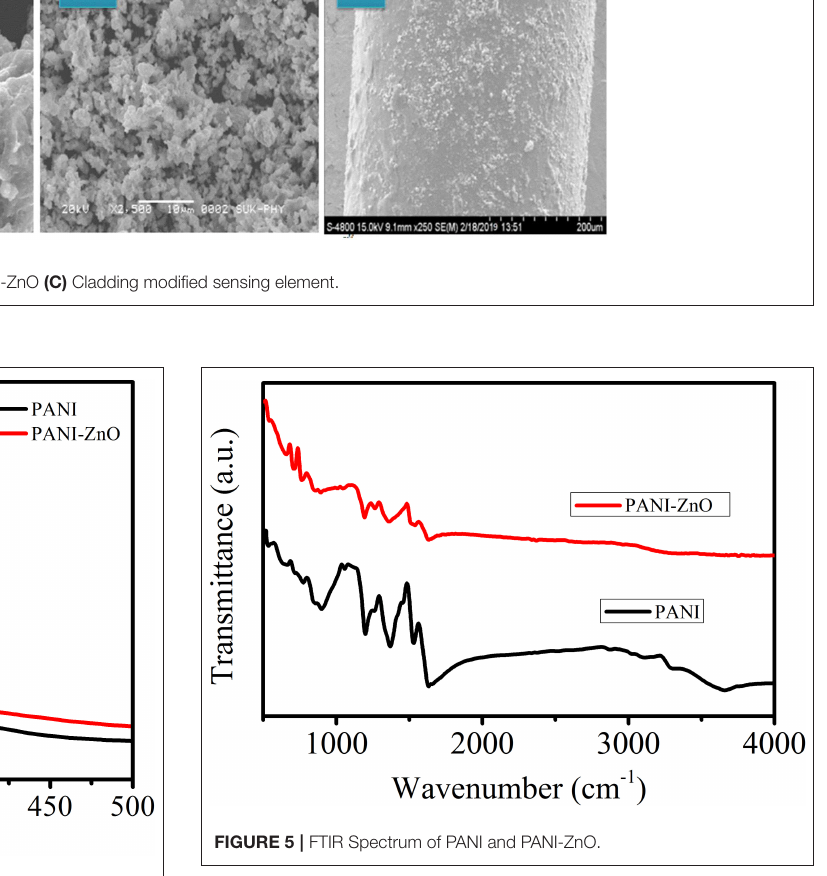
FIGURE 4 | UV-Vis Spectrum of PANI and PANI-ZnO.